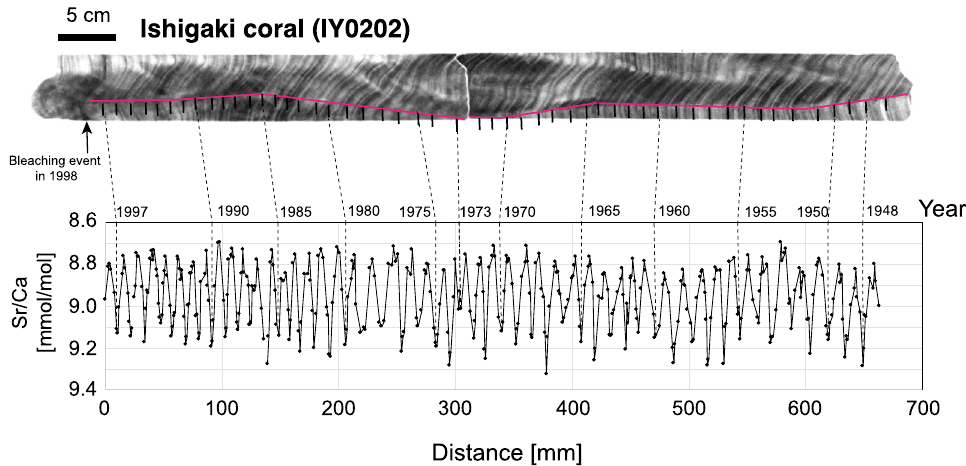
Figure 3. Coral X-ray photos and corresponding Sr/Ca for coral obtained from Ishigaki Is. Age model of the corals discussed here (i.e. from Ishigaki 13 and from Guam 57 ) are established through coupling layer counting of X-ray images and Sr/Ca measurements of corals. Sr/Ca can provide sea surface temperature information so that growth bands of corals can independently